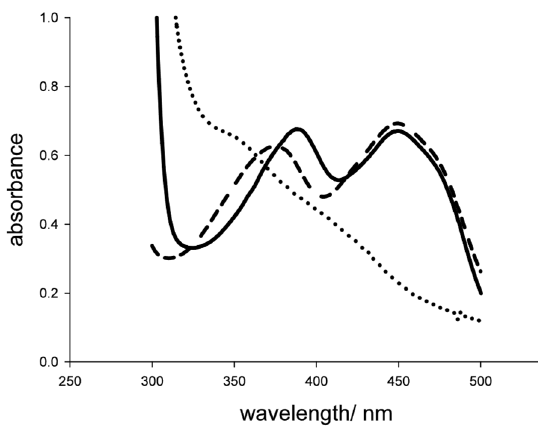
Figure 2. UV-Vis spectra of Sc POx in its oxidized form (solid line), after addition of 4 M D -xylose under aerobic conditions (dotted line) and of the supernatant after TCA precipitation (dashed